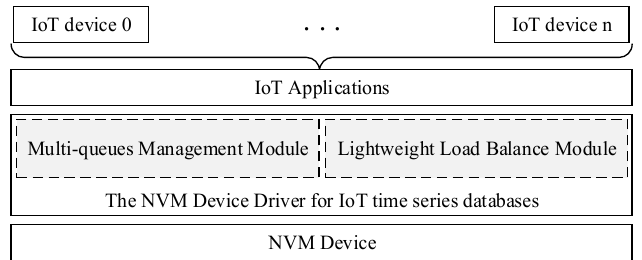
Figure 1. The NVM device driver for IoT time series databases.